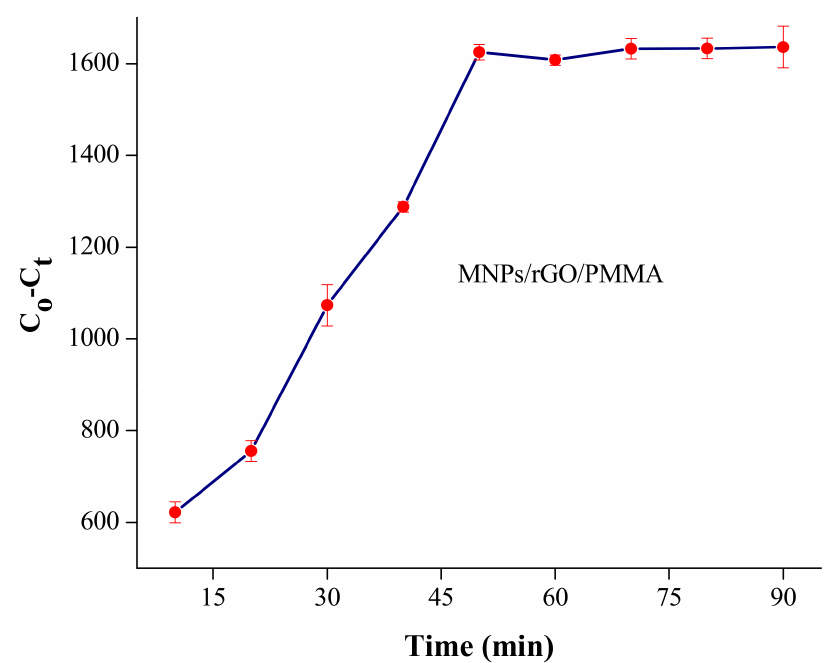
Figure 6. Effect of shaking time on adsorption of Cr(VI) on MNPs/rGO/PMMA composite; adsorbent amount, 150 mg; sample volume, 10 mL; pH